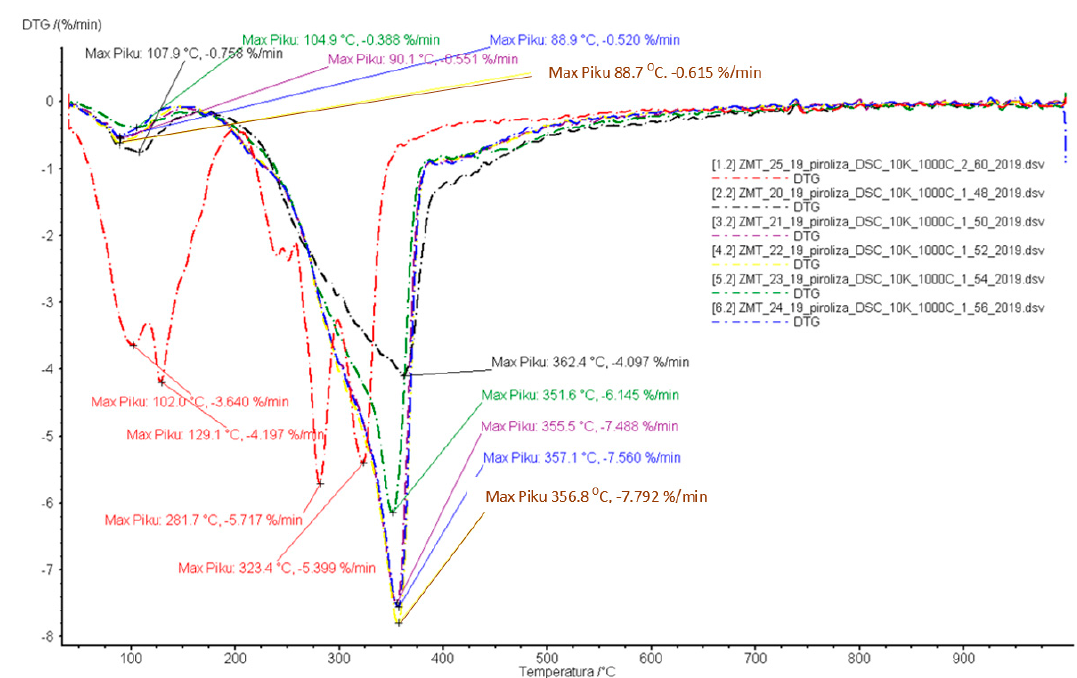
Figure 3. Derivative thermogravimetric measurements (DTG) curves of all samples tested (own research).